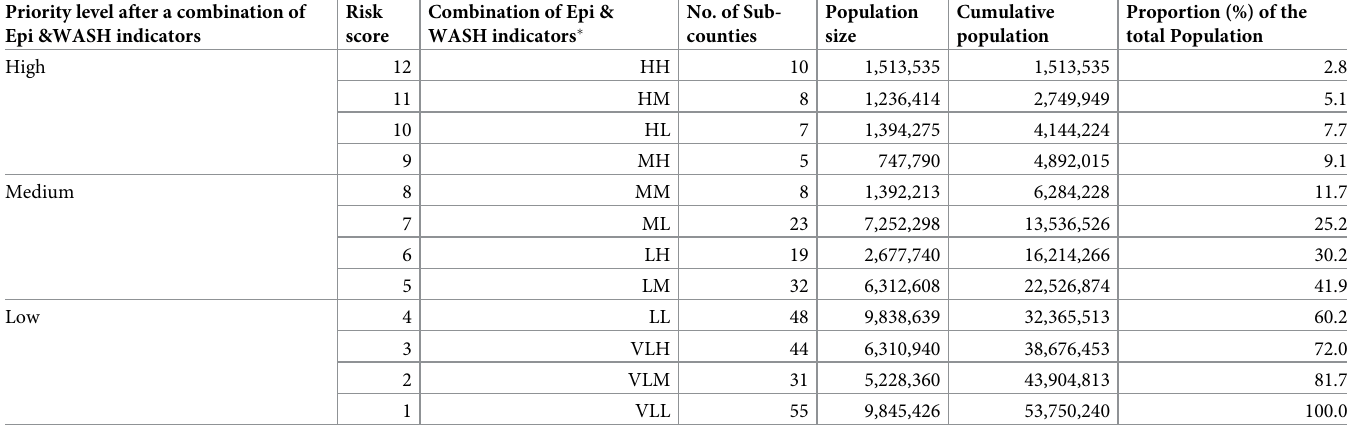
Fig 10. Priority sub-counties in Garissa County based on a combination of Epidemiological and WASH indicators, 2015- 2019. Link to base map layer: https://data.humdata.org/dataset/cod-ab-ken Link to terms of use: https://data.humdata.org/faqs/licenses. https://doi.org/10.1371/journal.pntd.0011166.g010 highest incidence areas comprise a small proportion (4%) of the continent [24]. By deploying effective targeted interventions, the study found that prioritizing high-risk areas could Table 3. Population sizes by priority